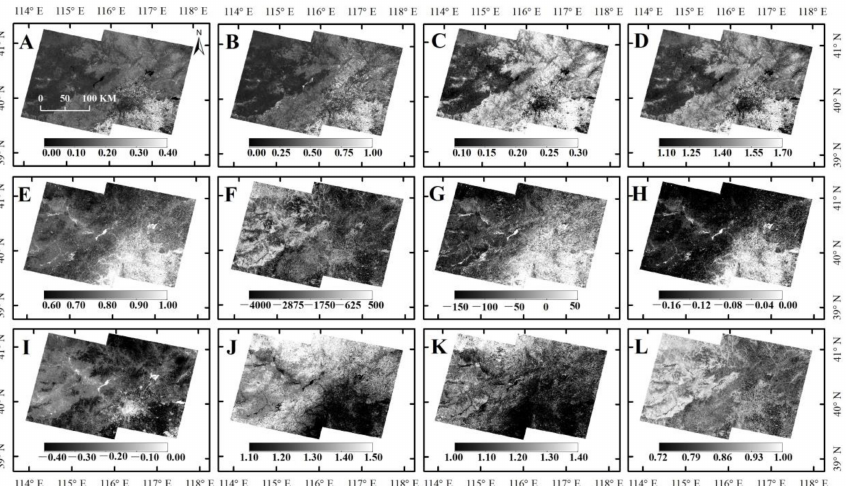
Figure 8. The spatial distribution of Normalized Difference Vegetation Index (NDVI) ( A ), Enhanced Vegetation Index (EVI) ( B ), Soil-Adjusted Vegetation Index (SAVI) ( C ), Ratio Vegetation Index (RVI) ( D ), Char Soil Index (CSI) ( E ), Mid-IR Bispectral Index (MIRBI) ( F ), Normalized Burn Ratio (NBR) ( G ), Normalized Difference Moisture Index (NDMI) ( H ), Normalized Differenced Water Index (NDWI) ( I ), SWIR1/NIR ( J ), SWIR2/NIR ( K ), and SWIR2/SWIR1 ( L ) over the overlapped TM/ETM+ images of 2001.